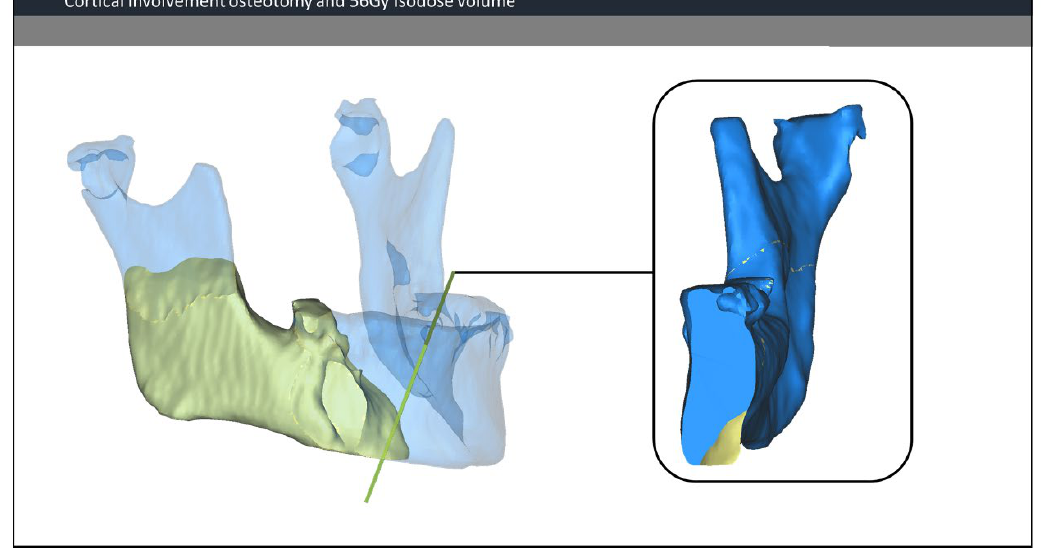
Figure 2. Cortical involvement osteotomy and 56Gy isodose volume. On the left, an overview of the mandible and the 56Gy isodose volume (yellow). The osteotomy plane is visualized in green. On the right side, a view perpendicular to the osteotomy plane. In this case, only the lingual cortex is involved.